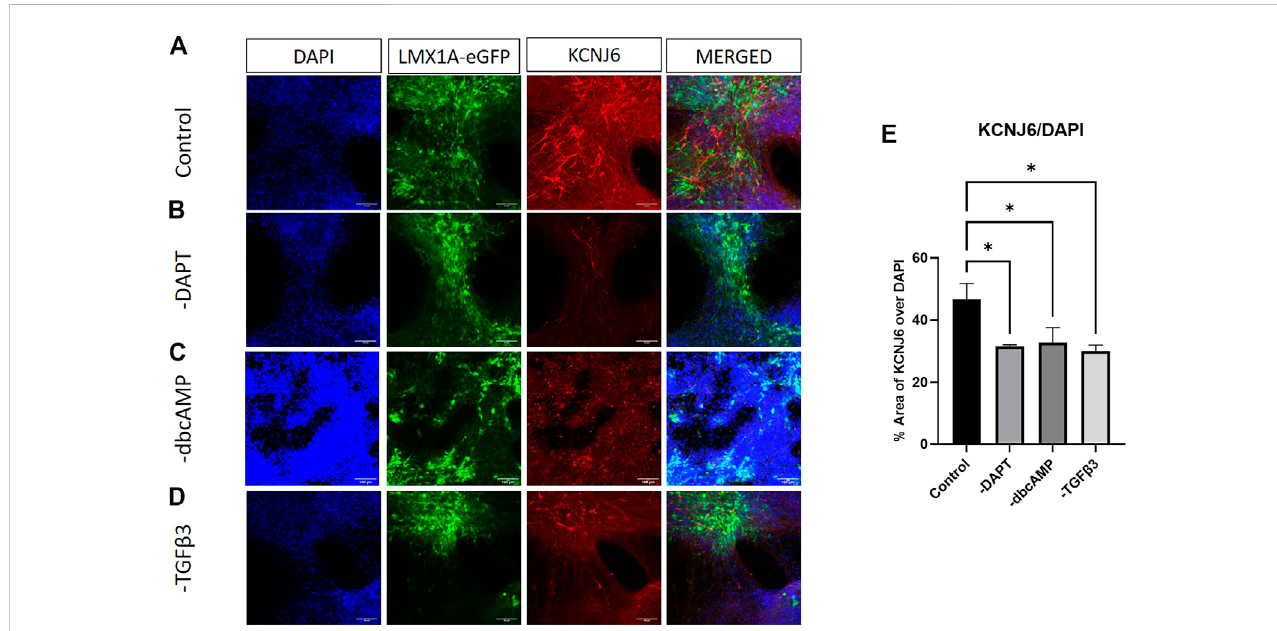
FIGURE 6 Immunolabelling of KCNJ6 in LMX1A-eGFP cultures. Panel (A) shows, from leftto right,DAPI nuclear labelling (blue), LMX1A-eGFP fl uorescence (green), KCNJ6(red)andacolorcombinedimage(merged).Panels (B – D) showthecorrespondingdata,butfollowingcultivationintheabsenceofDAPT,dbcAMPand